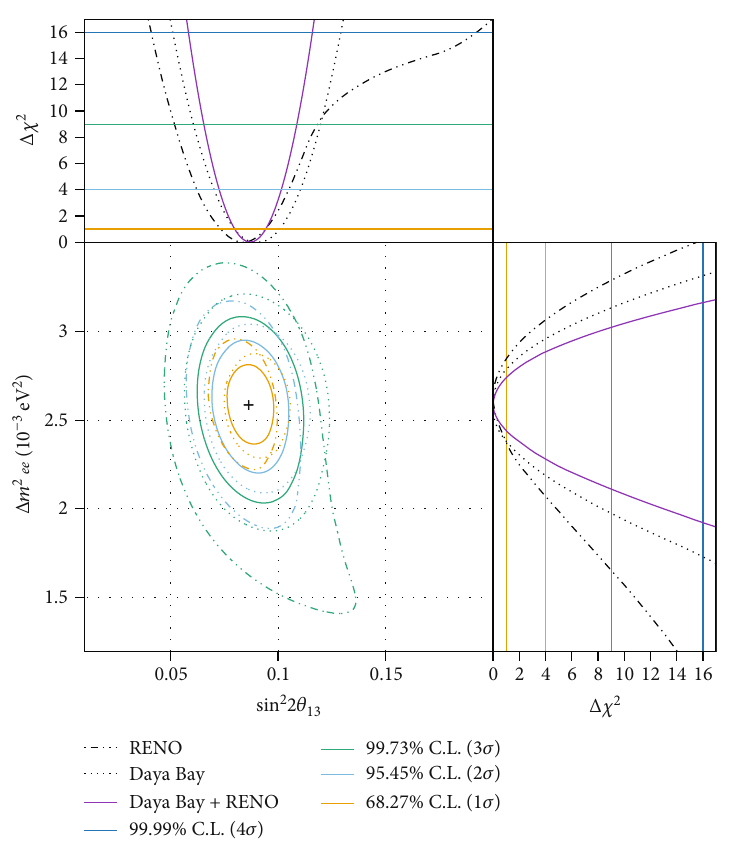
Figure 10: 2D regions (1, 2, and 3 σ ) and 1D intervals (1, 2, 3, and 4 σ ) allowed for the oscillation parameters obtained from the combination of Daya Bay and RENO data, using the spectral analysis. The best fi t is marked by a “ + ” in the central plot. The results from the independent analyses (RENO dot-dashed; Daya Bay dotted) are shown for